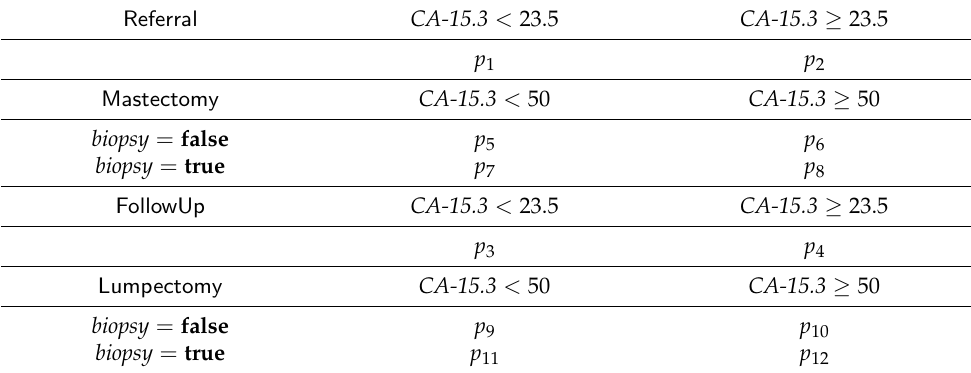
Table 2. Definition of the atoms from Figure 2 in terms of partitioning over the elementary intervals. Referral CA-15.3 < 23.5 CA-15.3 ≥ 23.5 p 1 p 2 Mastectomy CA-15.3 < 50 CA-15.3 ≥ 50 biopsy = false p 5 p 6 biopsy = true p 7 p 8 FollowUp CA-15.3 < 23.5 CA-15.3 ≥ 23.5 p 3 p 4 Lumpectomy CA-15.3 < 50 CA-15.3 ≥